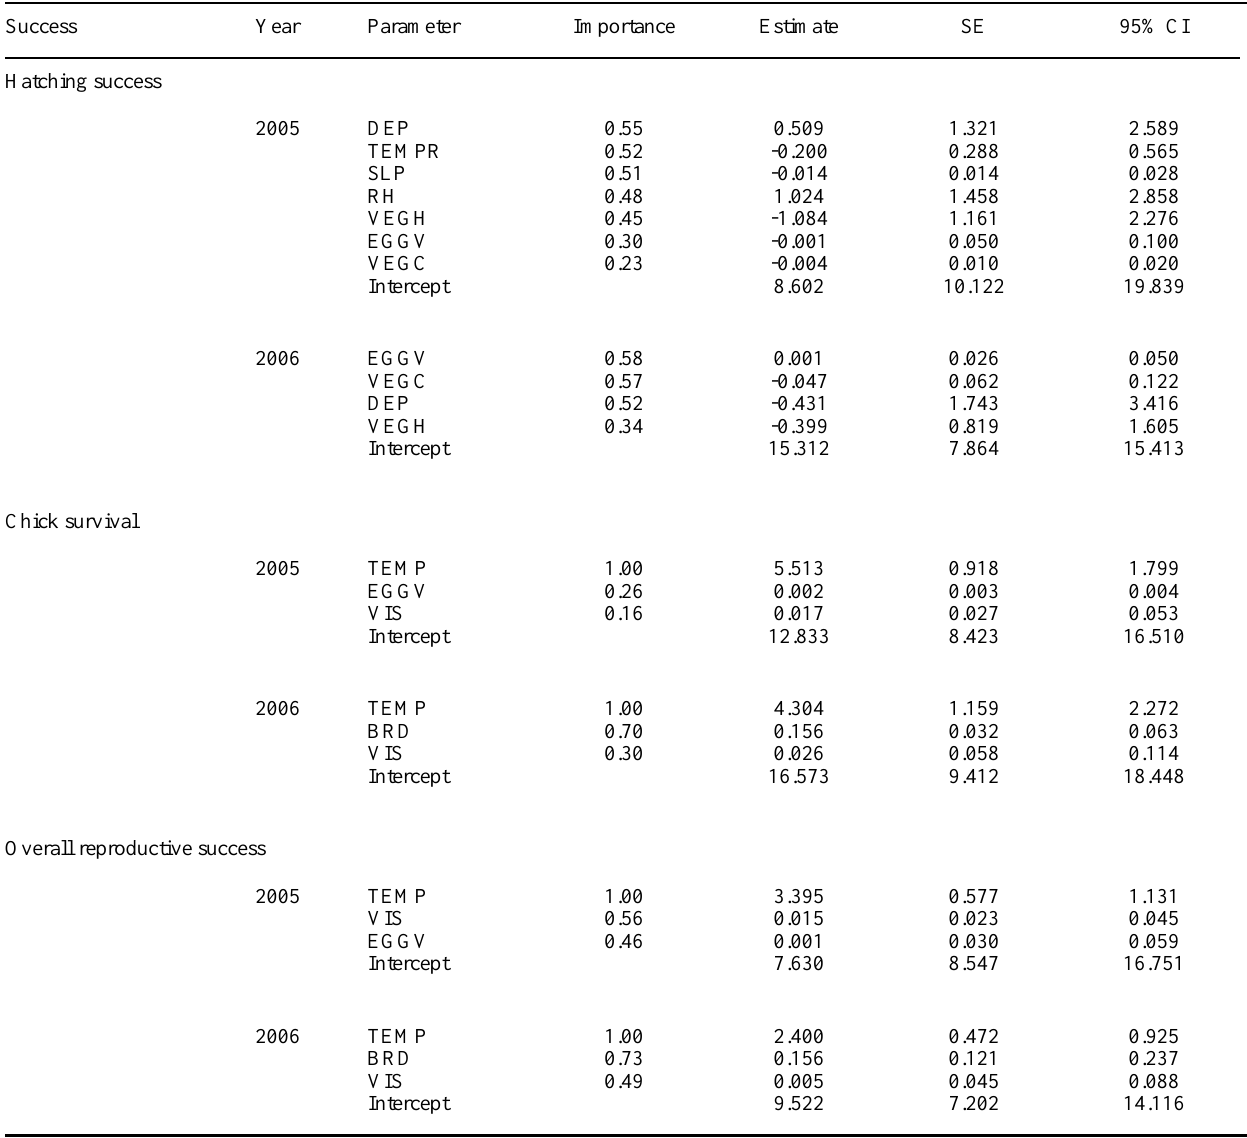
Table 2 . Importance values, model-averaged parameter estimates, and associated unconditional standard errors (SE) and 95% confidence intervals (CI) for parameters predicting hatching success, chick survival, and overall reproductive success in Fork-tailed Storm-Petrel ( Oceanodroma furcata ) nests at Kasatochi Island, Alaska. Parameters are listed in order of importance for each success variable in each year based on importance values; only those appearing in competing models ( D AIC duration data are available only for